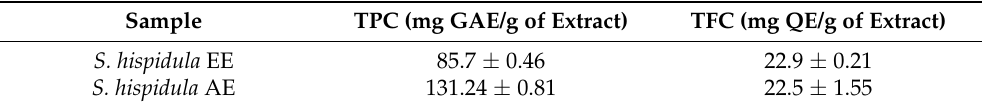
Table 1. Total phenolic and flavonoid contents of S. hispidula extracts. Sample TPC (mg GAE/g of Extract) TFC (mg QE/g of Extract) S. hispidula EE 85.7 ± 0.46 22.9 ± 0.21 S. hispidula AE 131.24 ± 0.81 22.5 ± 1.55